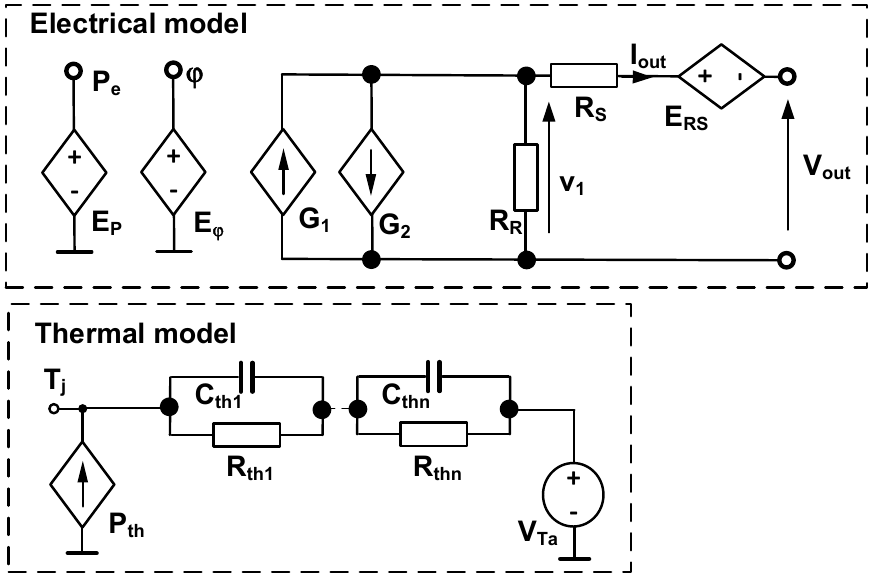
Figure 2. Network representation of the electrothermal model of two chains of PV panels connected in parallel.